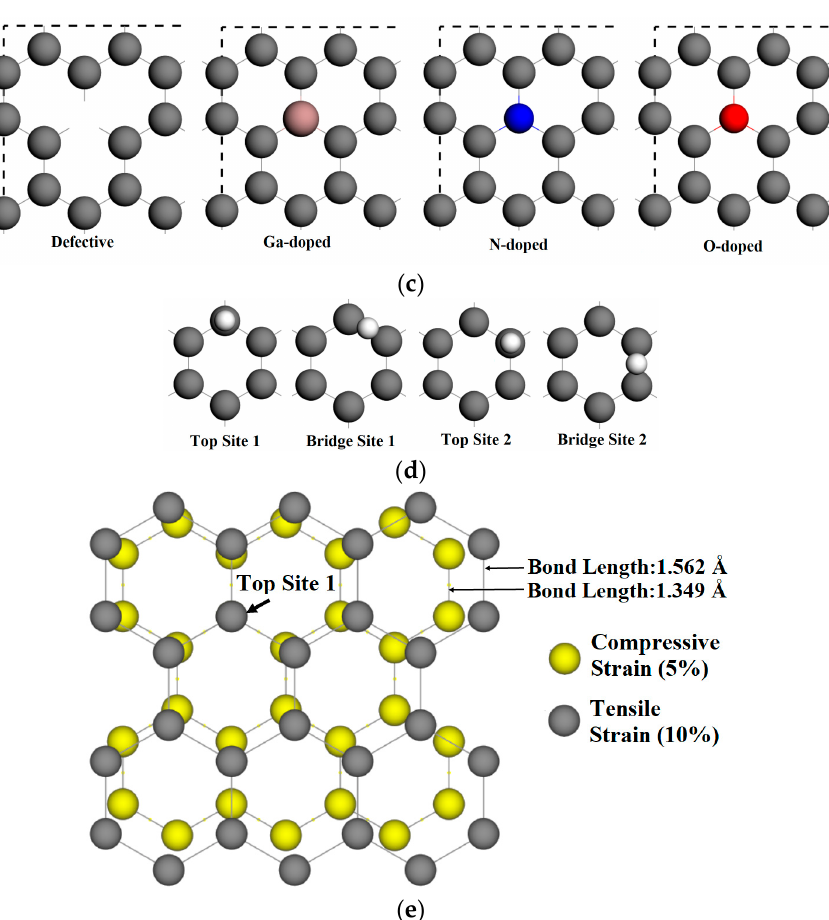
Figure 1. The top view and side view of calculation model. ( a ) 3 × 2 of the represented pristine graphene surface; ( b ) Monolayer graphene substrates and vacuum layer; ( c ) Vacancy-defected and doped graphene surfaces, where the dangling bonds are presented in the vacancy-defected graphene surface; ( d ) Four adsorption sites for atomic gallium and nitrogen on graphene, where Top Site 1 is just above the vacancy or doped atom; ( e ) The structure of strained graphene in the two limit cases.